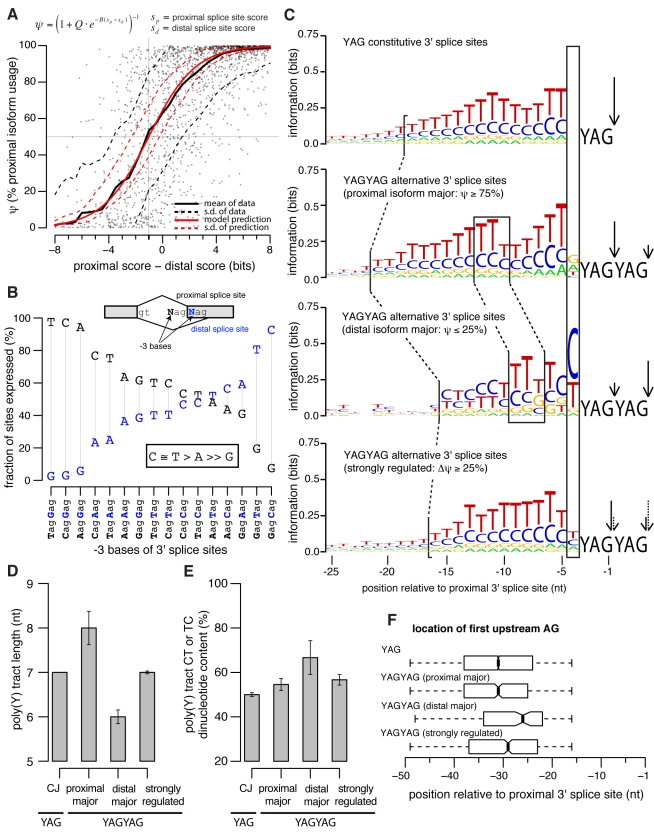
Variation in 3′ splice site features are associated with differences in NAGNAG splicing.(A) A simple biophysical model of NAGNAG splicing accurately models mean isoform usage across tissues as a function of difference in 3′ splice site score. Each point represents a single human NAGNAG, and the solid and dashed black lines show the mean ψ (across values for individual NAGNAGs with similar splice site score difference, with sliding window of 3.25 bits) and the standard deviation about the mean. The solid red line shows the prediction based on the model for parameters Q = 0.55 and B = 0.58, and the dashed red line indicates the standard deviation about the model mean expected from measurement error. The horizontal and vertical dashed lines indicate the splice site score difference (approximately 1 bit) at ψ = 50%. (B) The −3 bases largely determine whether a NAGNAG is alternatively spliced. We grouped NAGNAGs in the human genome according to their −3 bases and computed the fraction of each group which expressed the proximal (black) or distal (blue) isoform at ≥5% in at least one tissue. (C) Constitutive 3′ splice sites (top, YAG), YAGYAGs which express the proximal isoform at ≥75% in all tissues (middle, YAGYAG proximal major), YAGYAGs which express the distal isoform at ≥75% in all tissues (middle, YAGYAG distal major), and strongly regulated YAGYAGs (bottom, YAGYAG strongly regulated) all exhibit distinct upstream sequence preferences. The x-axis shows the position relative to the 3′ splice site (YAG) or proximal 3′ splice site (YAGYAG), and arrows indicate the 3′ splice site that is predominantly used. Figure was created with WebLogo [53]. Human and mouse YAGYAGs were grouped together to increase the statistical signal for (C–F). (D) Distal major YAGYAGs have shorter polypyrimidine tracts (p<0.001 relative to proximal major class, Kolmogorov-Smirnov test). Plot shows median length of the polypyrimidine tract, estimated as the first stretch of ≥5 consecutive pyrimidines upstream of the −3 position. Error bars indicate the standard deviation of the median, estimated by bootstrapping (the error bars for “CJ” were too small to be visible). (E) Distal major YAGYAGs have higher CT and TC dinucleotide content (p<0.005 relative to proximal major class, Kolmogorov-Smirnov test). Median CT and TC dinucleotide content of the polypyrimidine tract, computed as the fraction of the polypyrimidine tract composed of CT dinucleotides, with an optional T at the beginning or C at the end. Error bars indicate the standard deviation of the median, estimated by bootstrapping. (F) The AG exclusion zone [57] is more distally located in distal major YAGYAGs (p<0.001 relative to proximal major class, Kolmogorov-Smirnov test). Position of the first AG dinucleotide upstream of the −15 position is shown. Thick bars indicate the median positions, and boxes extend from the first to third quartiles.